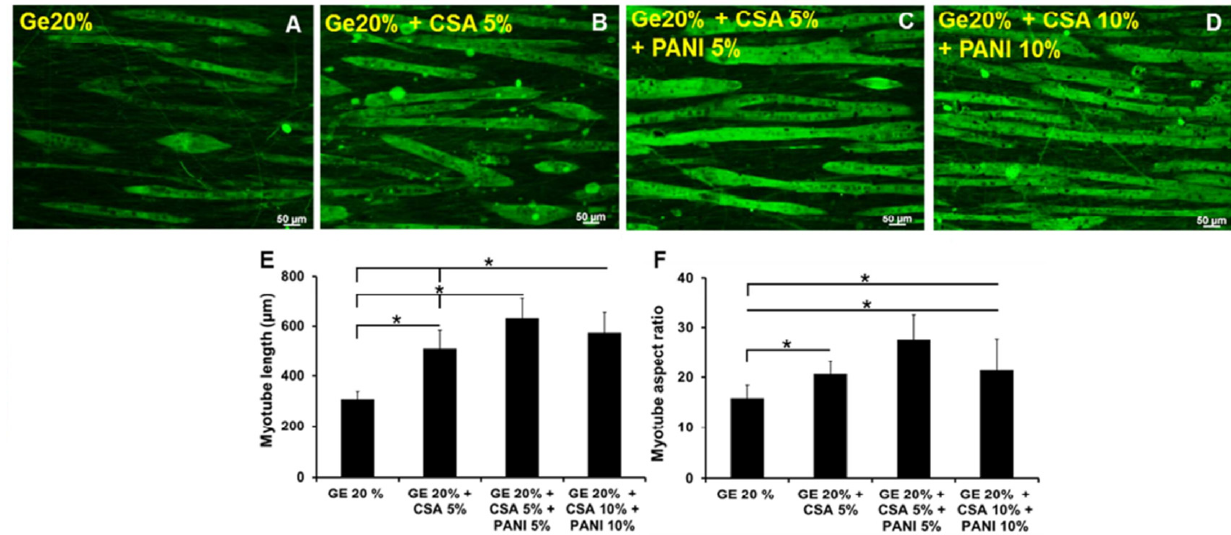
Figure 11. Effect of PANI addition to myotube formation and alignment. ( A ) Gelatin 20%, ( B ) Gelatin 20% + CSA 5%, ( C ) Gelatin 20% + CSA 5% + PANI 5%, ( D ) Gelatin 20% + CSA 5% + PANI 10%, ( E ) Myotube length quantification, and ( F ) Myotube aspect ratio quantification. * Significant difference between the groups ( p < 0.001). Adapted with permission from [183]. Copyright (2017) American Chemical Society.